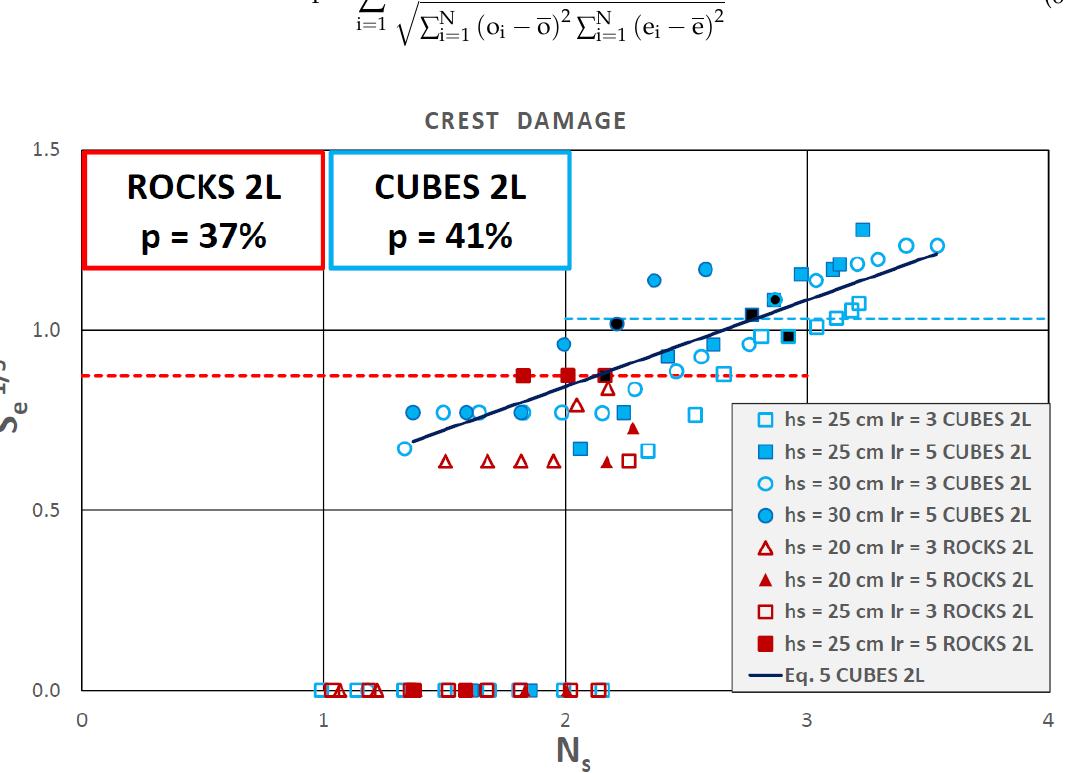
J. Mar. Sci. Eng. 2018 , 6 , x FOR PEER REVIEW Figure 7. Measured armor damage, S e , to the crest as a function of the stability number (rock and cube armors).